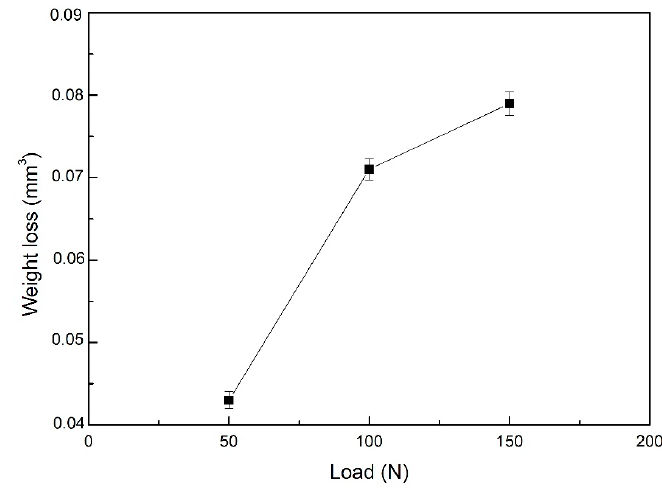
Figure 10. Weight loss as a function of the applied load.